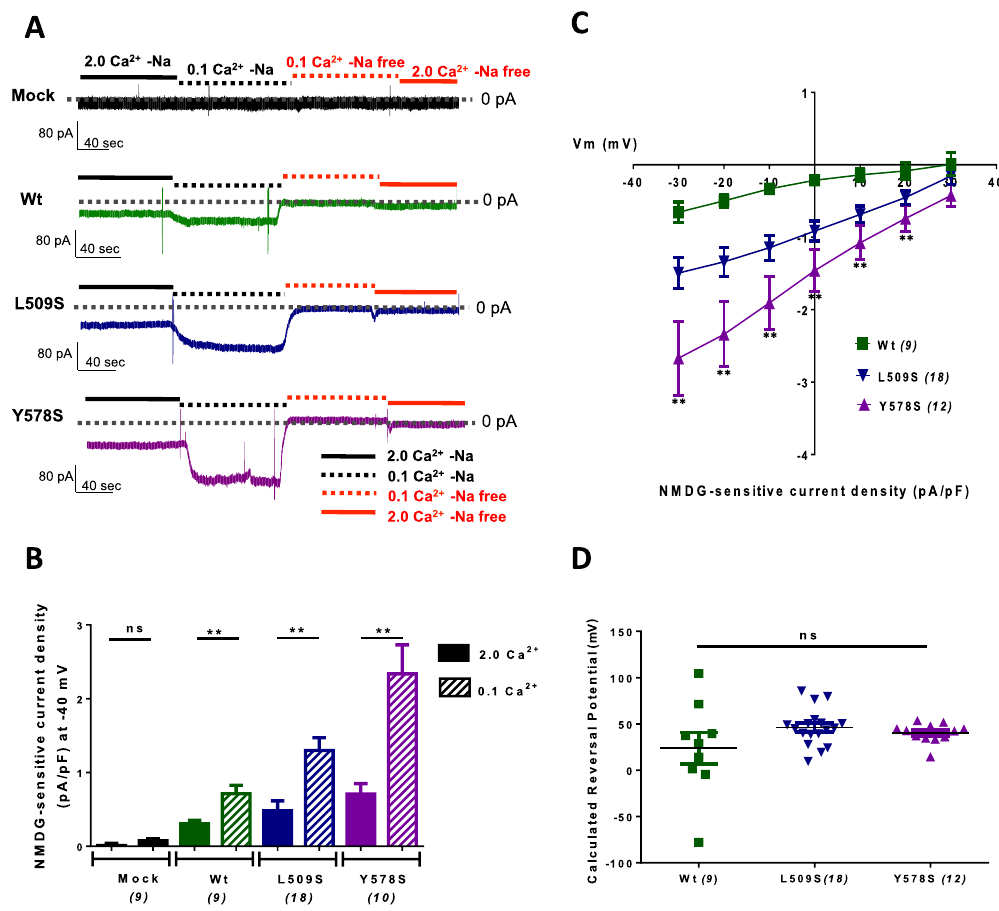
Figure 6. The NALCN current for wt, Y578S and L509S variants is potentiated in low extracellular Ca 2 + with no change in reversal potential. (A ) Representative traces obtained on cells held at − 40 mV (HP) during application/wash of an extracellular Na + -free solution (replaced with NMDG) with high (2 mM) or low (0.1 mM) extracellular Ca 2 + for a mock (NLF1)-transfected cell, a NALCN/NLF1 (wt)-transfected cell, a NALCN CLIFAHDD mutant (L509S)/NLF1-transfected cell, and a NALCN CLIFAHDD mutant (Y578S)/ NLF1-transfected cell. ( B ) Density of the external Na + -dependent background current (Na + -free) with high (2 mM, filled bars) or low (0.1 mM, hatched bars) extracellular Ca 2 + for mock (NLF1)-transfected cells ( − 0.008 ± 0.029 pA/pF in [Ca 2 + ] e = 2 mM and − 0.073 ± 0.028 pA/pF in [Ca 2 + ] e = 0.1 mM, n = 9, P = 0.136), NALCN/NLF1 (wt)-transfected cells ( − 0.303 ± 0.046 pA/pF in [Ca 2 + ] e = 2 mM and − 0.712 ± 0.115 pA/ pF in [Ca 2 + ] e = 0.1 mM, n = 9, p = 0.004). NALCN CLIFAHDD mutant (L509S)/NLF1-transfected cells ( − 0.529 ± 0.148 pA/pF in [Ca 2 + ] e = 2 mM and − 1.347 ± 0.188 pA/pF in [Ca 2 + ] e = 0.1 mM, n = 16, P = 0.001), and NALCN CLIFAHDD mutant (Y578S)/NLF1-transfected cells ( − 0.792 ± 0.126 pA/pF in [Ca 2 + ] e = 2 mM and − 2.466 ± 0.415 pA/pF in [Ca 2 + ] e = 0.1 mM, n = 16, P = 0.001). Statistical significance was calculated with an unpaired student’s t test ( C ) I/V relationship in the − 30 mV to + 30 mV range of the Na + -dependent component recorded in low concentration of extracellular Ca 2 + (0.1 mM) of wt NALCN (n = 8), NALCN- Y578S (n = 12) and NALCN-L509S (n = 18) currents. ( D ) Mean reversal potential (E Rev ) of the Na + -dependent component of wt NALCN (E rev = 36.55 ± 12.91 mV, n = 8), NALCN-Y578S (E rev = 40.22 ± 2.99 mV, n = 12) and NALCN-L509S (E rev = 46.22 ± 4.70 mV, n = 18) currents. Each dot represents the E Rev of 1 cell. For each cell, the E Rev was calculated from the linear part of its I/V relationship as illustrated in ( C ). Statistical significance was calculated with a Tukey’s multiple comparisons